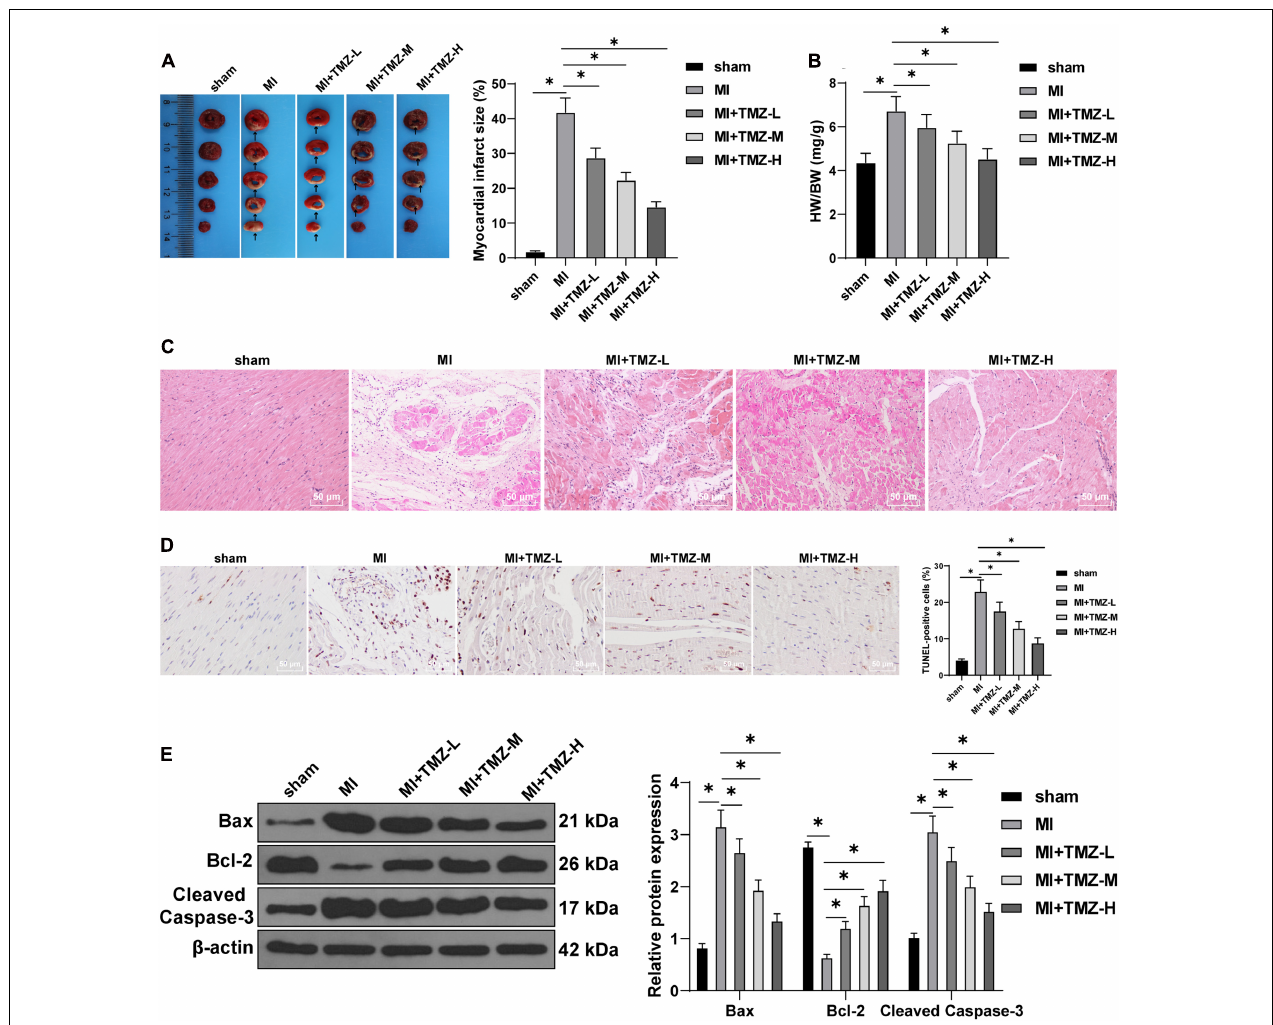
FIGURE 1 | Trimetazidine (TMZ) inhibited myocardial infarction (MI)-induced myocardial apoptosis. (A) MI was detected by triphenyltetrazolium chloride (TTC) staining. Areas in white represent the MI region. (B) Heart weight was measured and the heart/weight ratio calculated. (C) Pathological changes of the myocardial tissue were detected by hematoxylin–eosin (HE) staining. (D) Myocardial apoptosis was detected by transferase-mediated biotin-16-dUTP (TUNEL) staining. (E) Western blot analysis of Bax, Bcl-2, and cleaved caspase-3 ( N = 3 per group). Detection was repeated three times. All data were expressed as the mean ± standard deviation. Data were analyzed using one-way one-way analysis of variance (ANOVA), followed by Tukey’s multiple comparisons test. * P < 0.05.